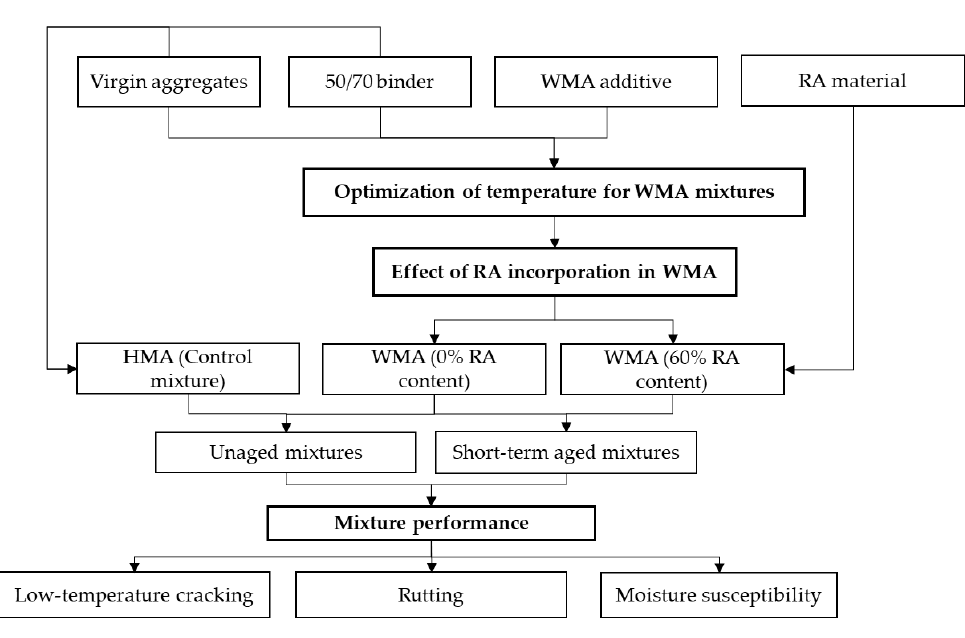
Figure 1. Experimental plan.